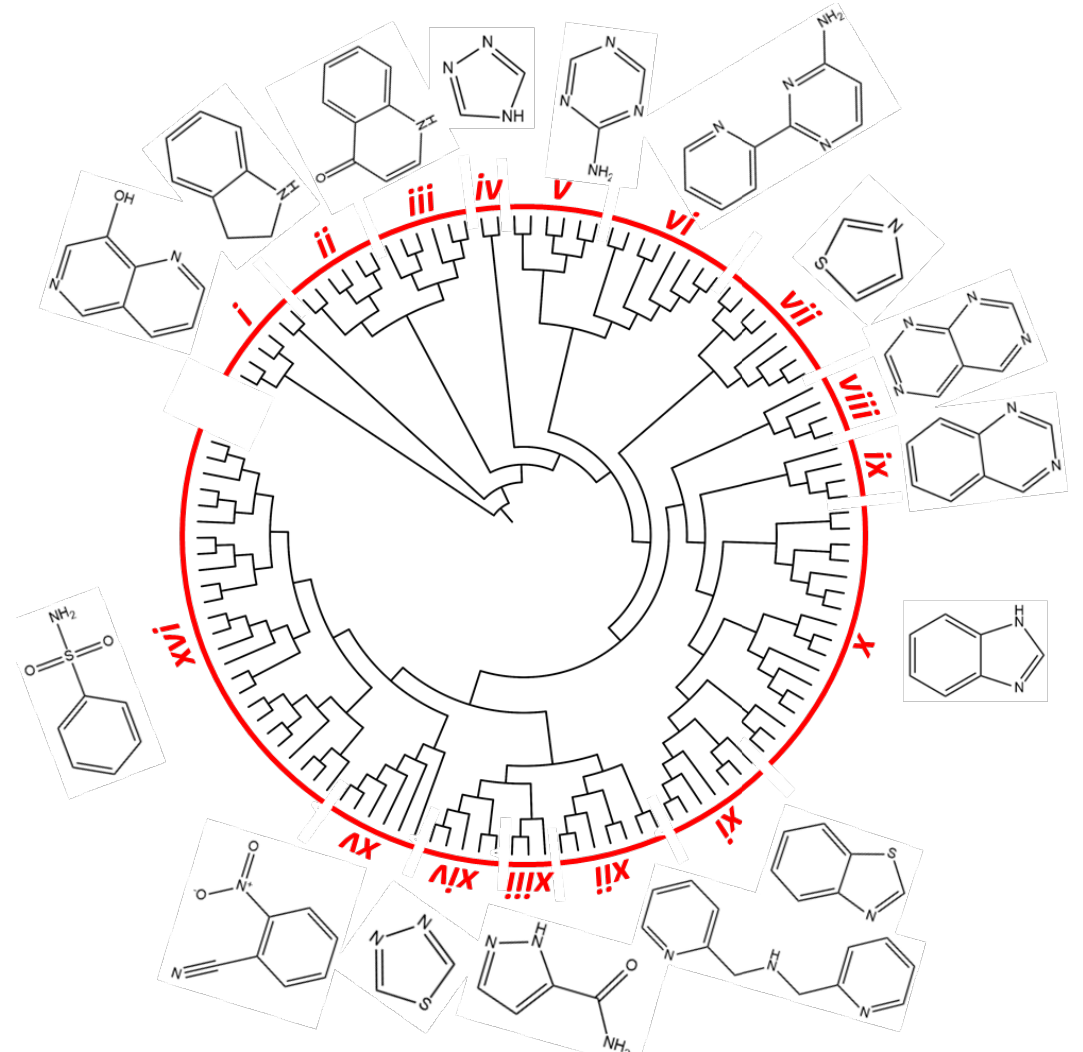
Figure 1. Similarity-based hierarchical clustering analysis. The figure shows the dendrogram of the Kinetobox compound library. Clustering analysis was based on the chemical similarity. Sixteen clusters were identified as the most representative of the entire compound collection; the chemical core structure of the cluster compounds is shown.